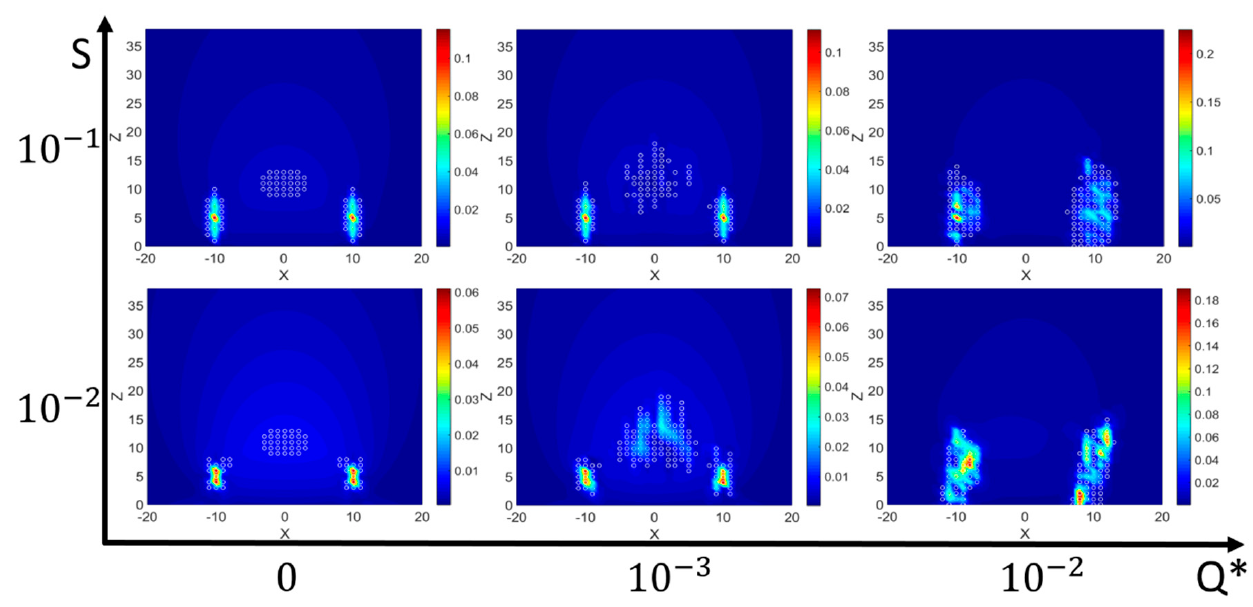
Figure 5. Effect of S and Q*, parameters characterizing the eigenstrain ε * of the nucleated events Equation (2), on the localization of plastic rearrangements at the 25th step of deformation with 10 events at each step, for Q = 0 (no disorder in the local thresholds) and initial defects ε xy = 10.1 ε d max . With our choice of loading F z , the maximum deviatoric strain ε d max due to Hertz contact in the absence of disorder is equal to 0.65 × 10 − 2 here.